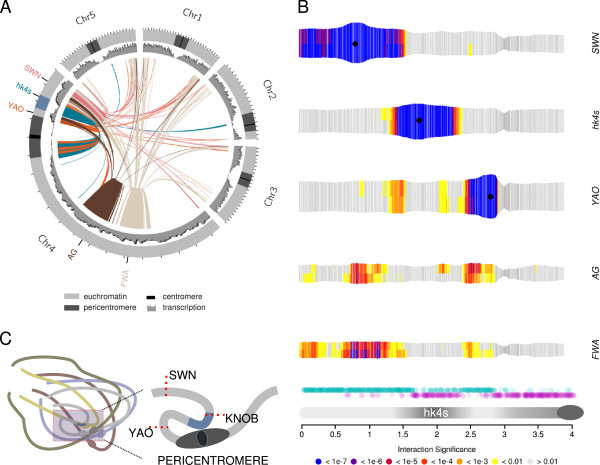
Interactome of the knob hk4s. (A) Circos plot illustrating all cis and trans interactions of viewpoints located on chromosome 4. Only interactions with P ≤ 10-4 were considered. Line color corresponds to the color of the viewpoints name indicated at the periphery of the plot. Chromosomes are not drawn to scale. (B) Representation of interaction frequencies for viewpoints situated on chromosome 4. Note that only the region up to 4 Mb is plotted, therefore, viewpoints AG and FWA cannot be seen. Black dots show positions of viewpoints; turquoise dots, genes; violet dots, transposable elements; light grey, euchromatic chromosomal segment; dark grey, heterochromatic chromosomal segments; dark grey ellipse, centromere. (C) Model of a potential mid-range chromosomal loop, connecting hk4s with the centromere of chromosome 4.